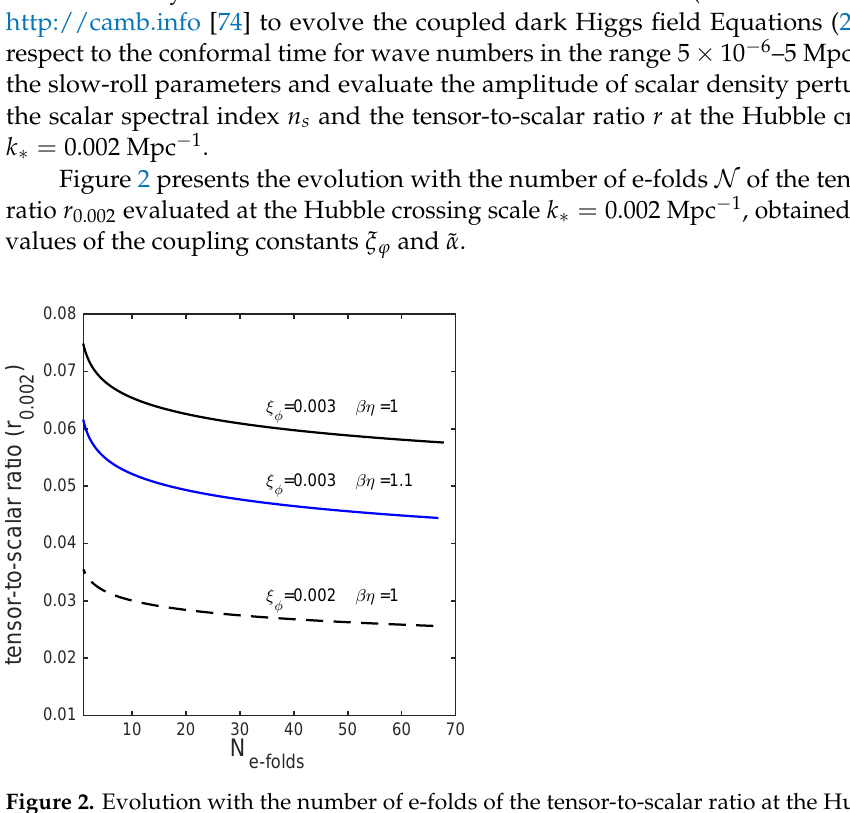
. Other coupling pl